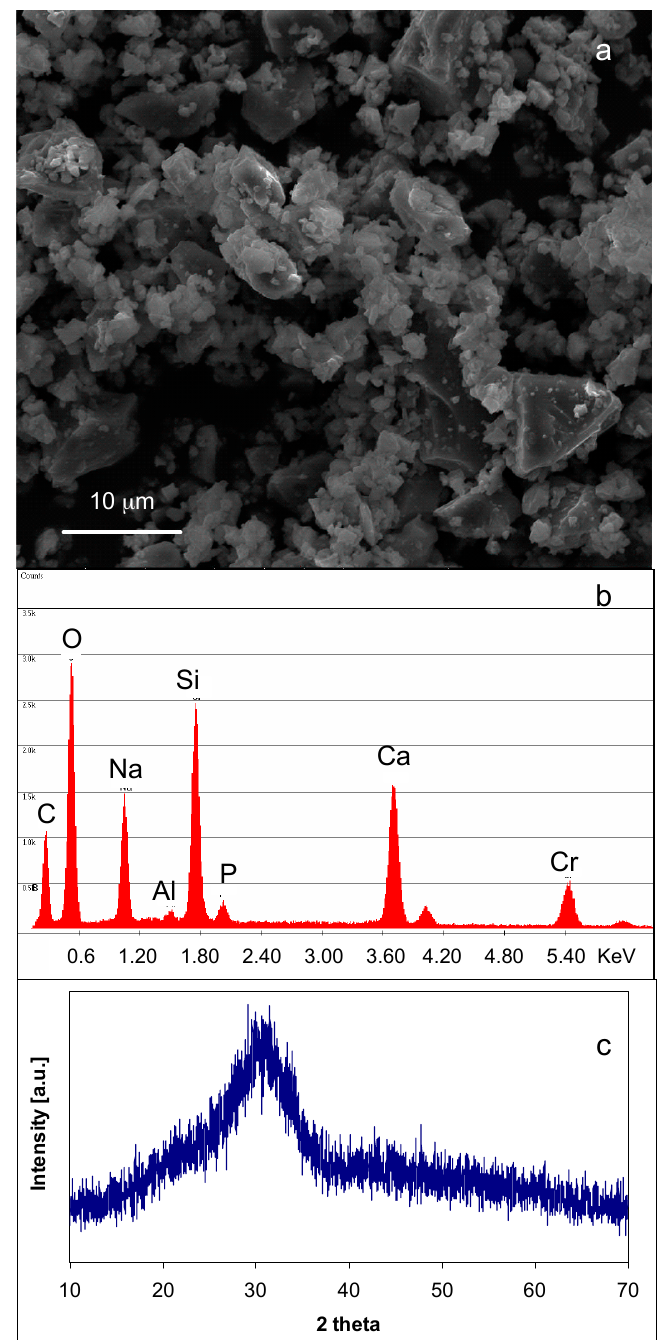
Figure 1. ( a ) Morphological; ( b ) compositional; and ( c ) structural analyses of SBA2 bioactive glass powders.